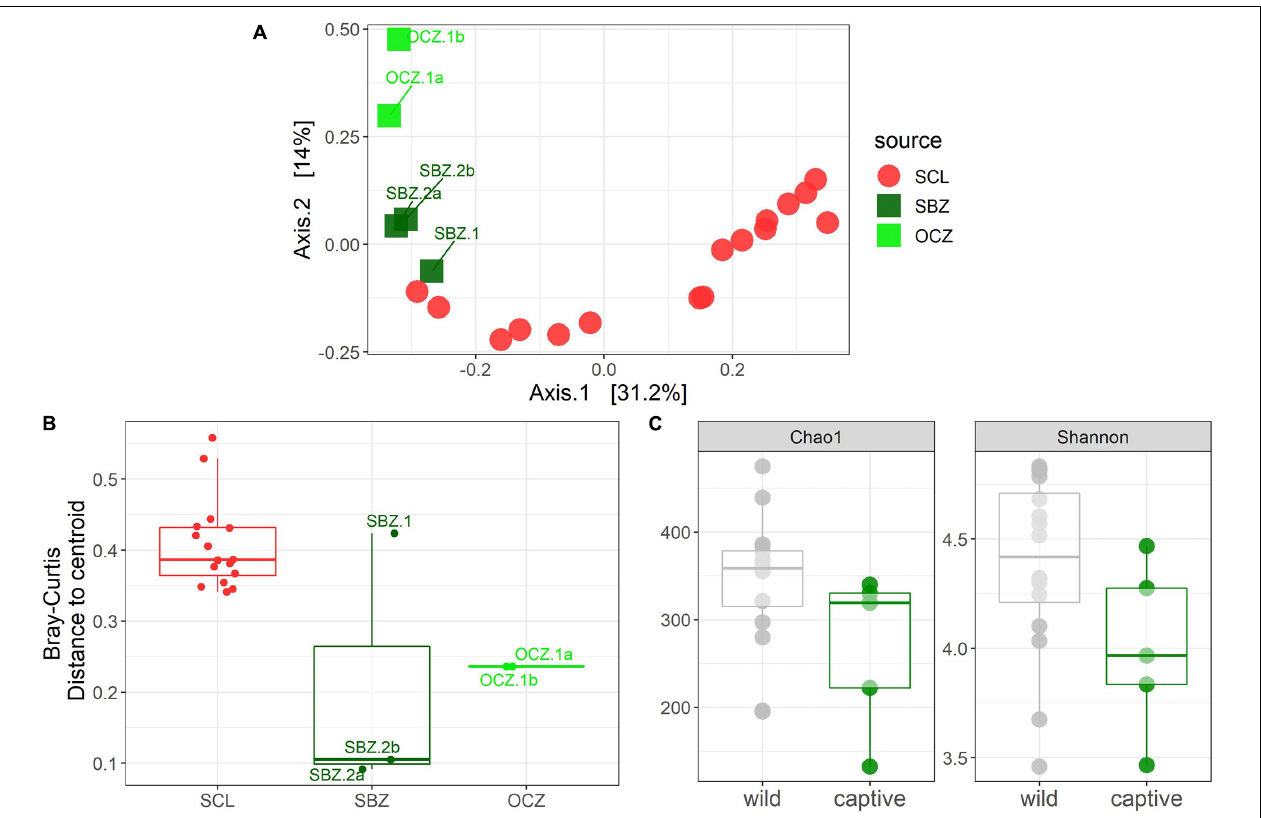
FIGURE 4 | (A) Principal coordinates analysis (PCoA) based on Bray–Curtis dissimilarity of samples from SCL and captivity (SBZ, OCZ). (B) Boxplot of multivariate dispersion as measured by the distance to the centroid per sample and displayed by source. (C) Chao 1 and Shannon diversity metrics between wild and captive